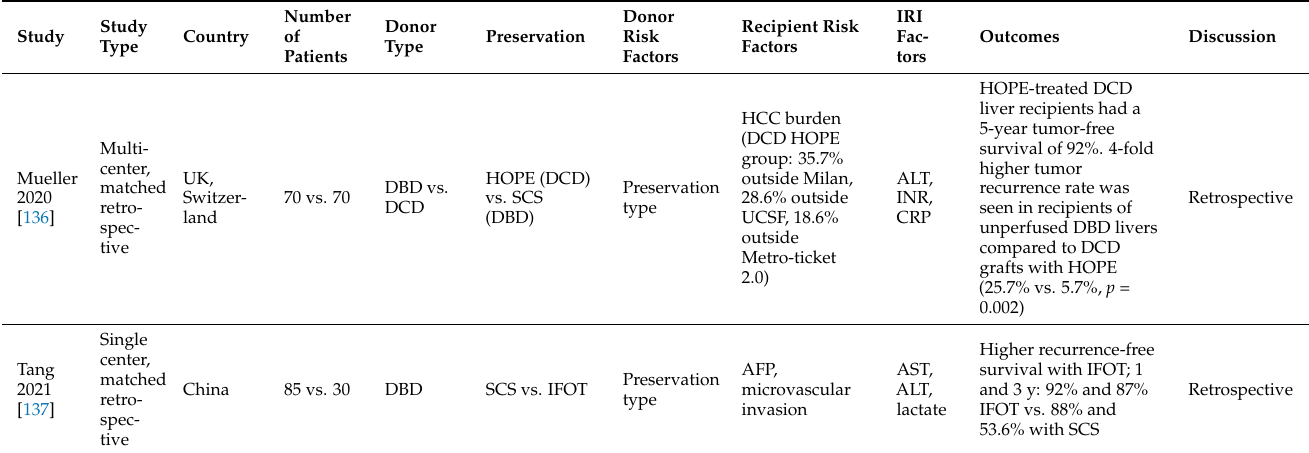
Table 2. Studies evaluating the impact of MP on IRI-associated HCC recurrence and recipient